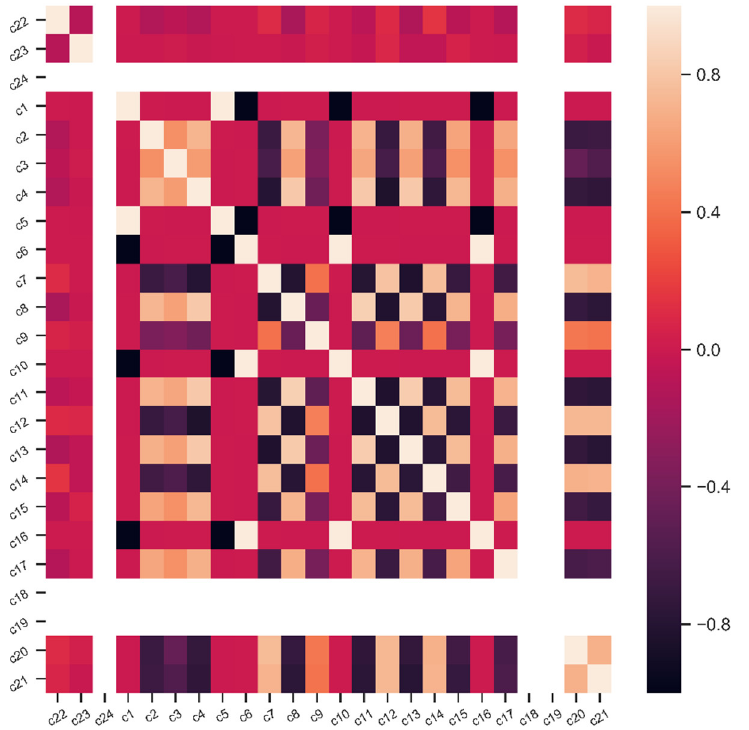
Figure 11. Correlation between elements in FD001.